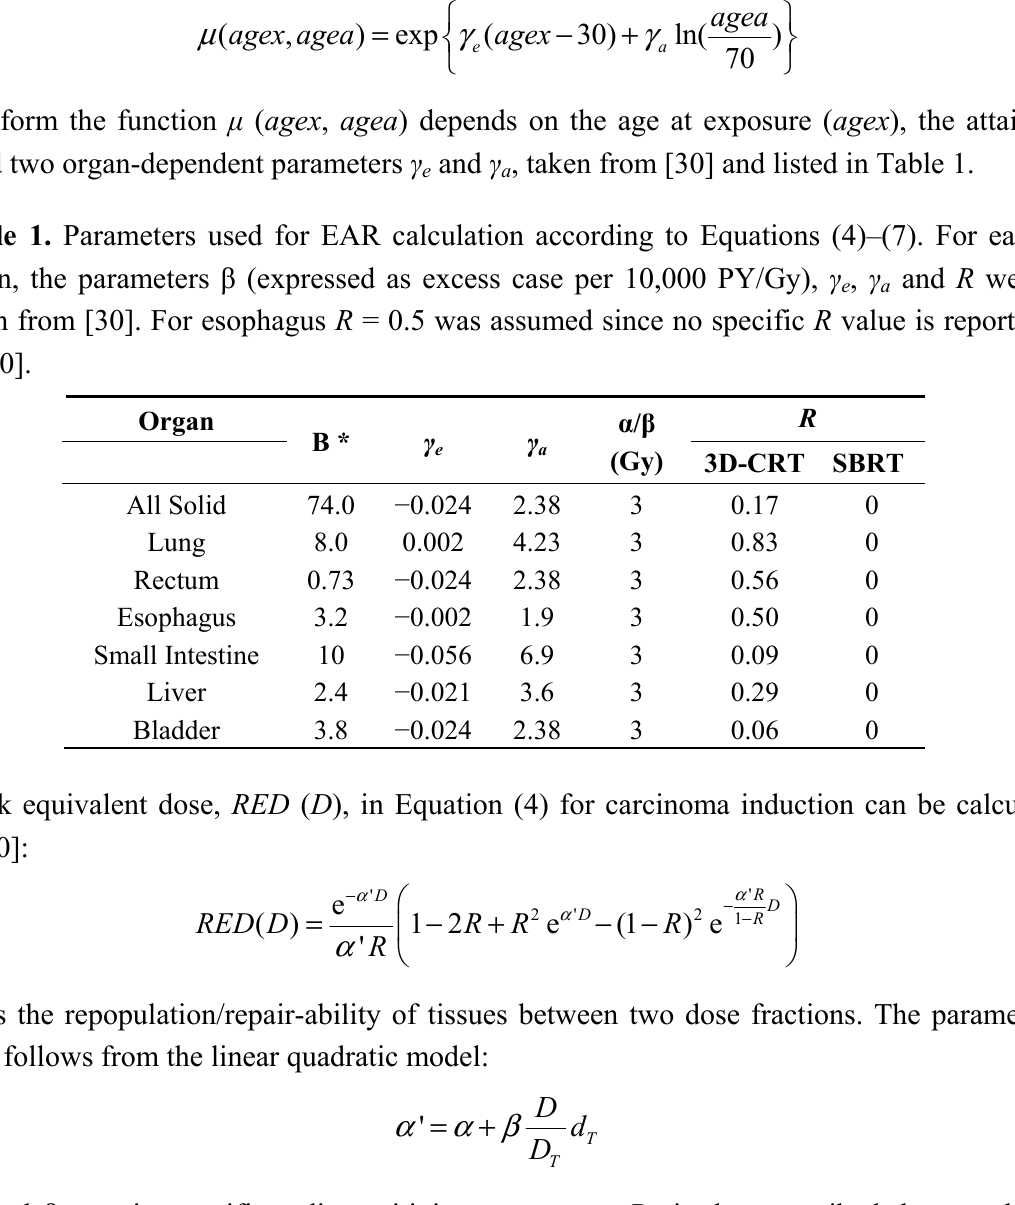
, γ and R were e a